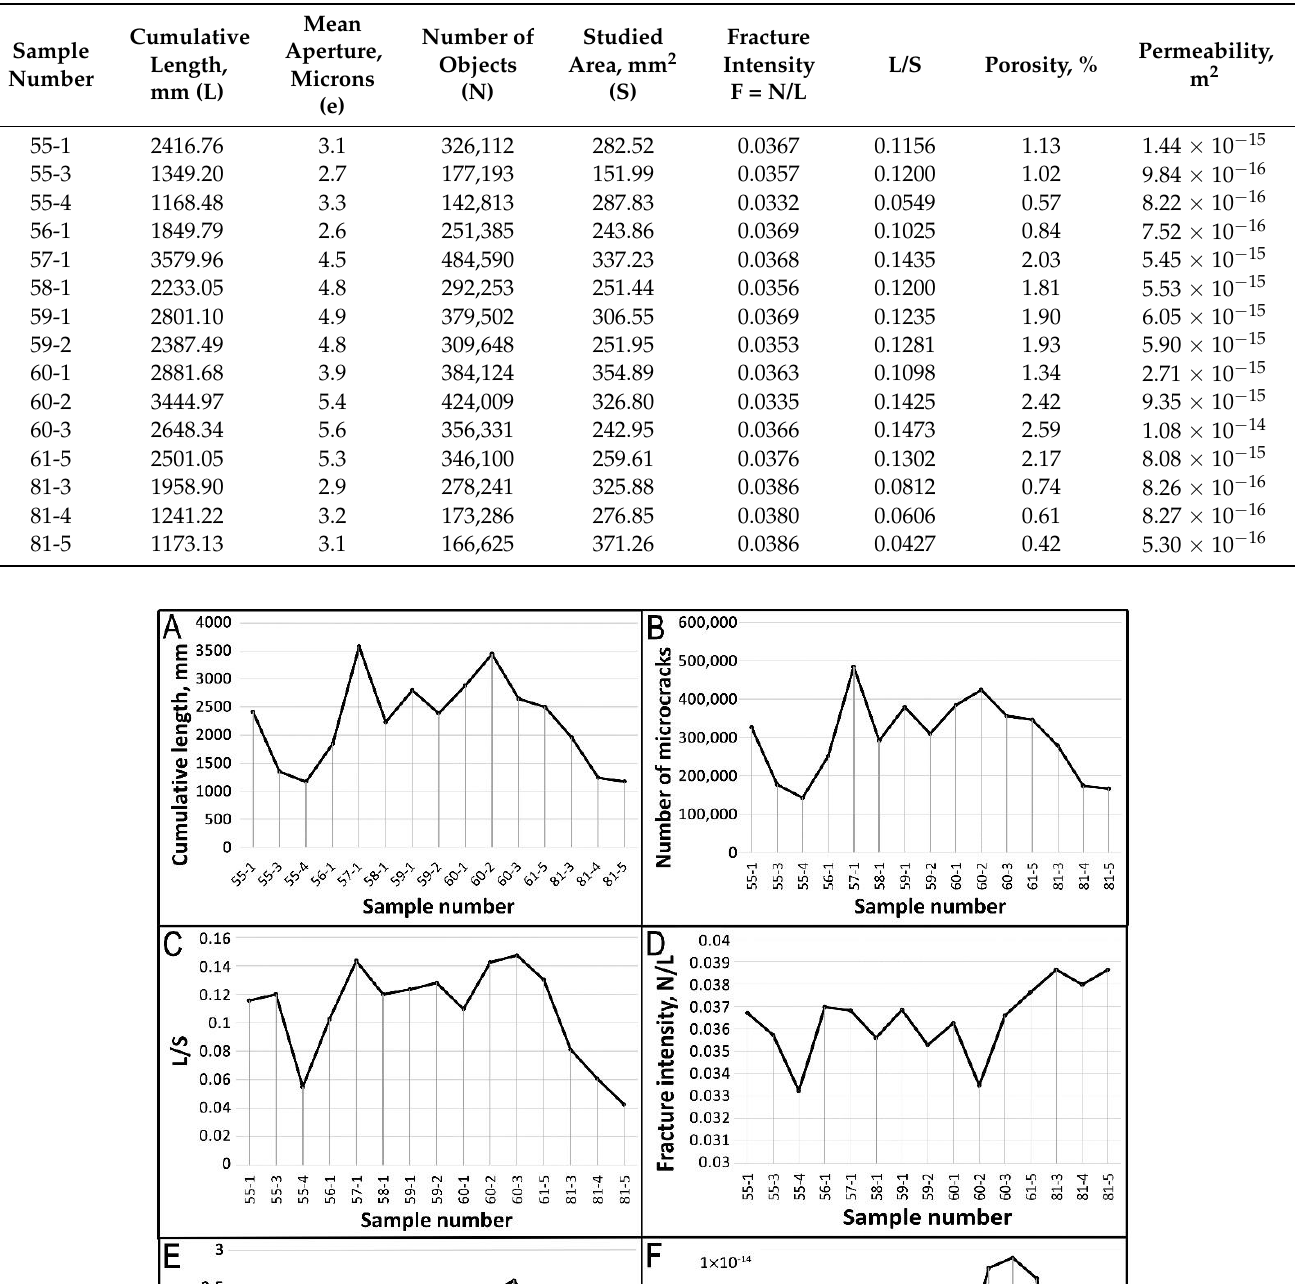
Figure 8. Graphs of the distribution of L/S ( A ) and N/L ( B ) versus permeability. Fracture density maps (P20) [100] of the identified microfractures were built to as- sess the most permeable zones in the thin section. These maps show the areal distribution of microfractures (Figure 9). Microfractures in the samples 56-1, 57-1, 59-1, 60-2, 60-3 and 61-5 have relatively uniform spatial distributions. In other thin sections, the distribution of microfractures is extremely uneven. Most often, the areas of maximum density of microfractures are con- fined to linearly elongated zones oriented in a certain manner. In sample 55-3, the density